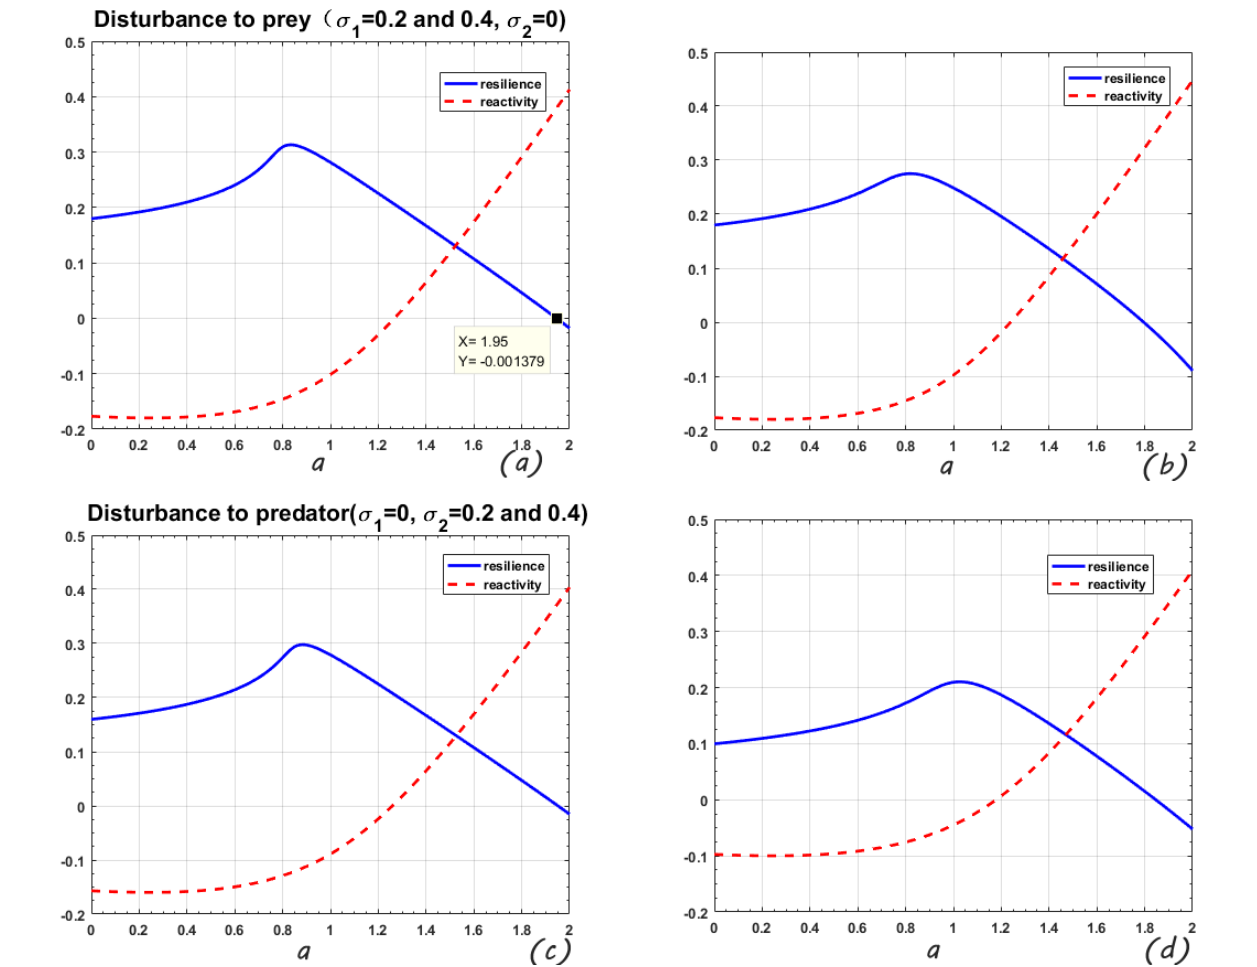
Figure 2. Resilience and reactivity (in the mean-square sense) of the positive equilibrium of (11). The variable parameter is a , fixed parameters b = 0.7808, c = 0.5. In ( a ), σ 1 = 0.2, σ 2 = 0. In ( b ), σ 1 = 0.4, σ 2 = 0. In ( c ), σ 1 = 0, σ 2 = 0.2. In ( d ), σ 1 = 0, σ 2 =